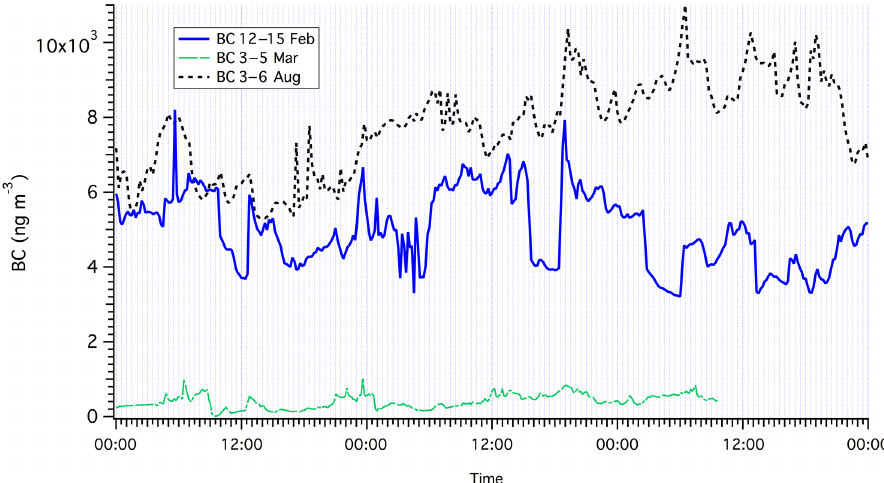
Figure 10. Case study of BC in a polluted period in February (blue line), a non-polluted period in March (green line), and a polluted period in August (dotted black